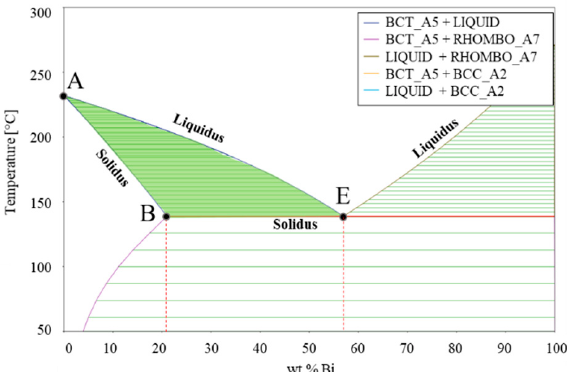
Figure A1. Sn-Bi binary phase diagram.